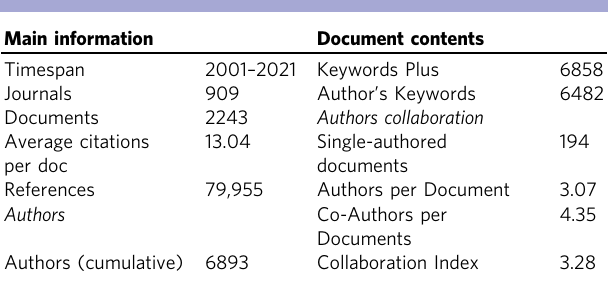
Table 1 Dataset